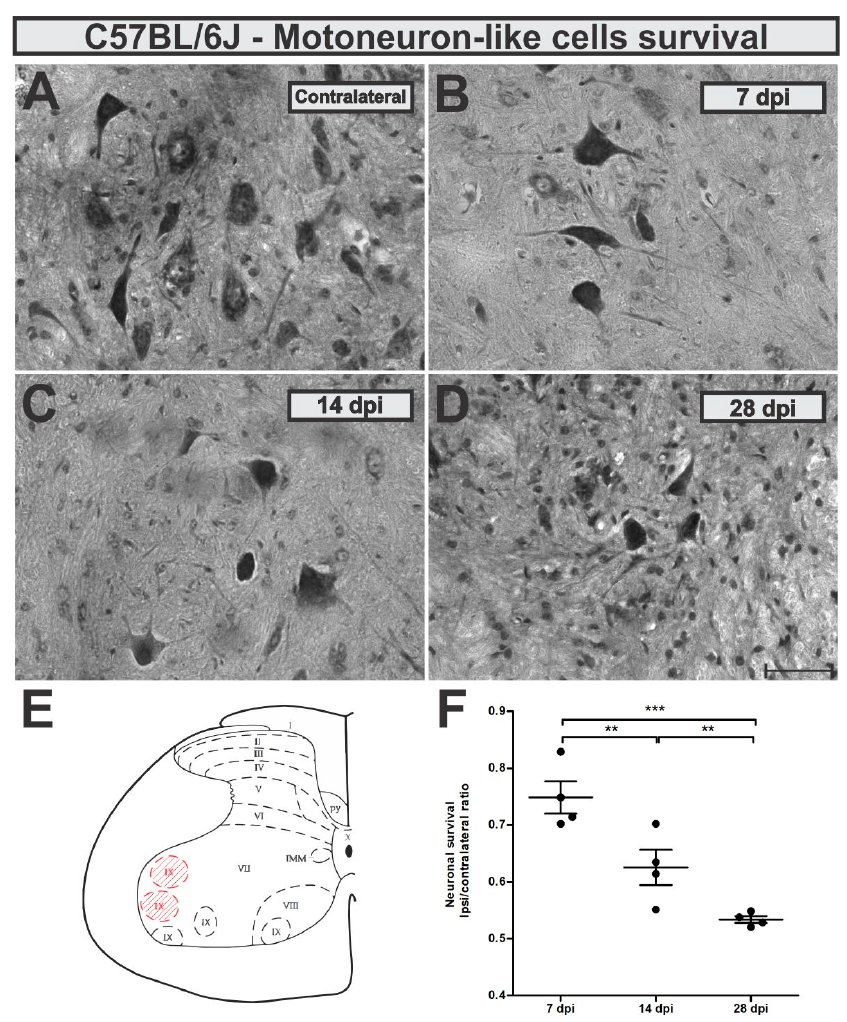
Figure 3. Time-course of motoneuron-like cell survival in the wild type (WT) mice ( A ) contralateral - unlesioned, ( B ) 7 days after injury (dpi), ( C ) 14 dpi and ( D ) 28 dpi. ( E ) Schematic spinal cord transverse section showing the laminae of Rexed distribution. Lamina IX is highlighted in red and represents the area where cell counting, and immunohistochemistry analysis were performed. ( F ) Neuronal survival at the time points after ventral root crush (ipsi / contralateral ratio); p < 0.01 (**), and p < 0.001 (***). Scale bar = 50 µ m.